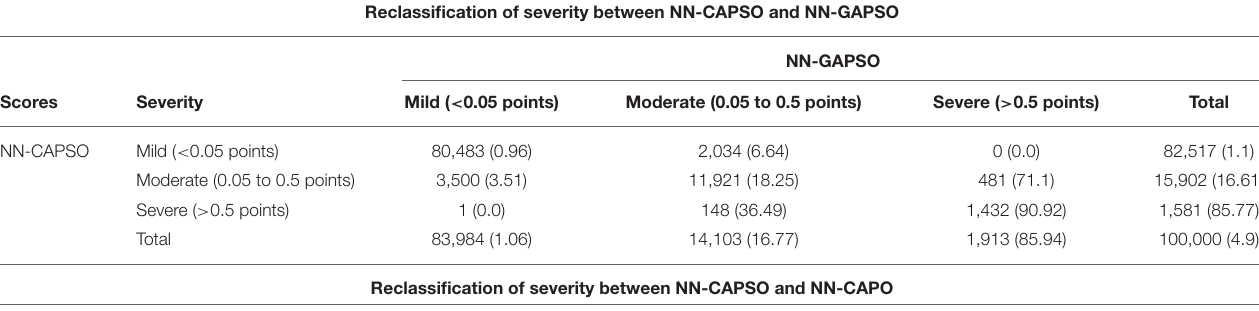
TABLE 4 | Reclassification of severity between NN-CAPSO and other scoring systems in the randomly selected validation cohort a . Reclassification of severity between NN-CAPSO and